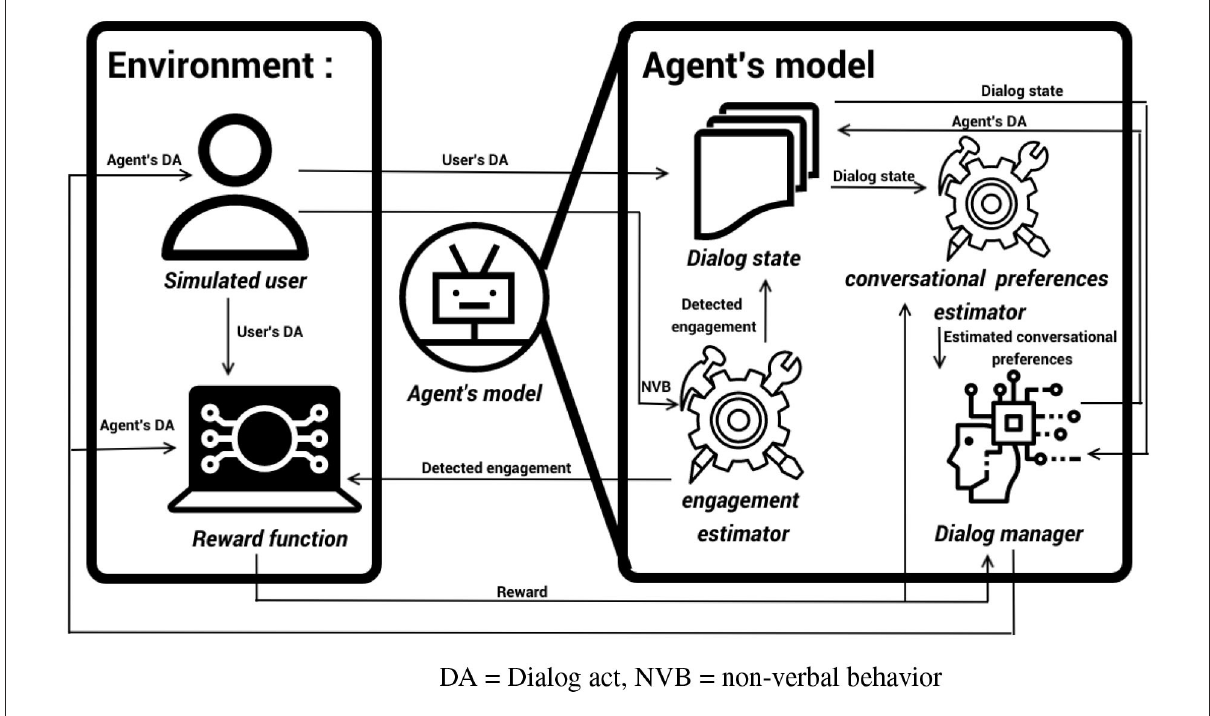
FIGURE1 System architecture. DA, dialog act; NVB, non-verbal